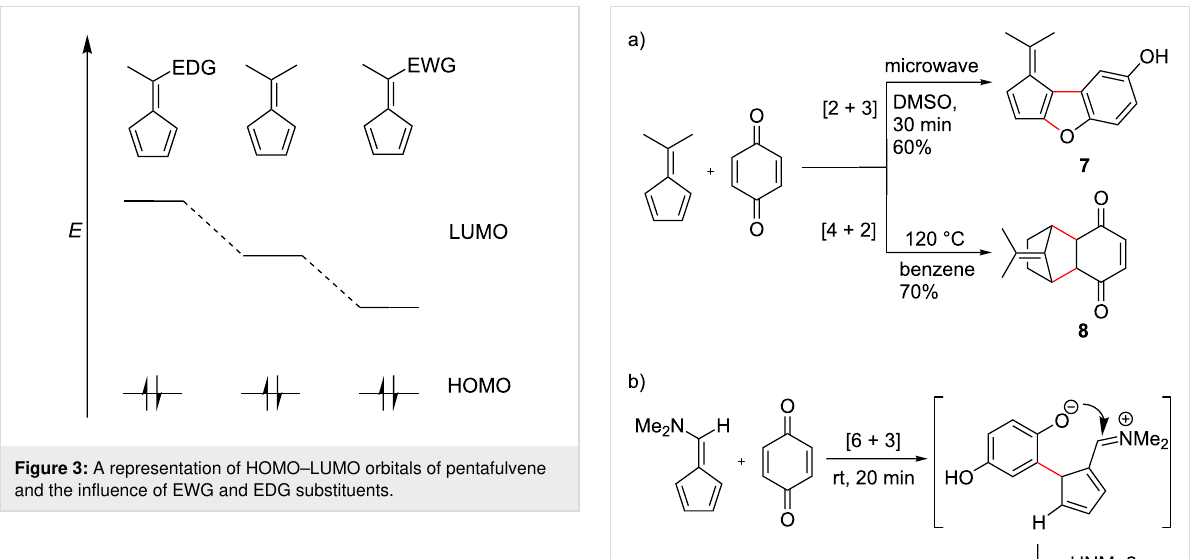
polycyclic scaffolds. In the subsequent sections, the cycloaddi- tion chemistry of fulvenes will be discussed in terms of their dimerization, and intra- and intermolecular reactions. Whereas the high reactivity and poor stability of triafulvenes have limited studies into their cycloaddition chemistry [1,2,4,10-12], the relative stability of pentafulvenes has allowed extensive research into their participation as 2 π , 4 π and 6 π